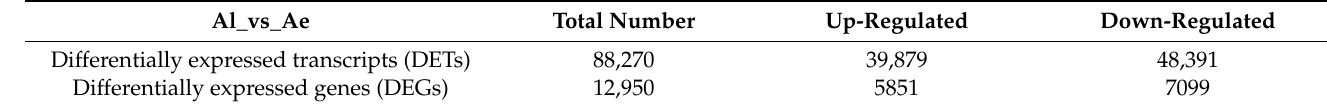
Table 2. Statistical table of number of differentially expressed transcripts and